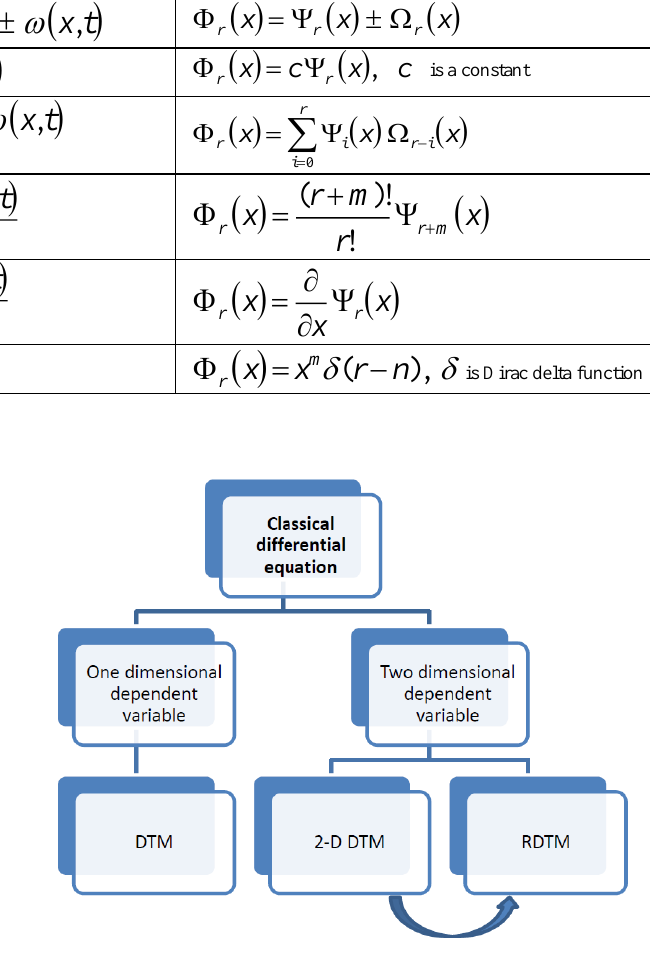
Figure 1. An overview of differential transforms